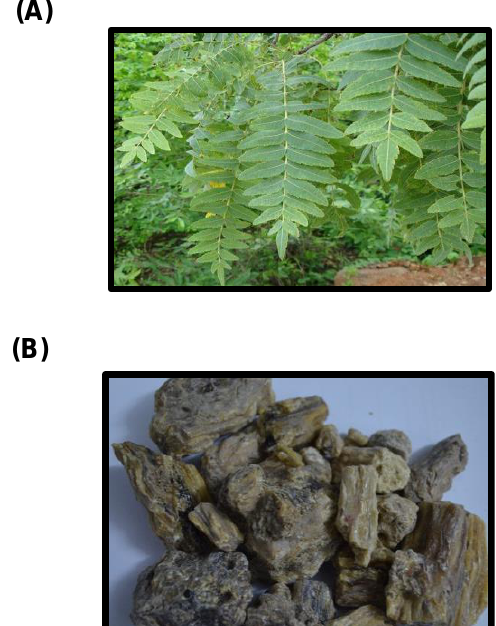
Figure 1. ( A ) Boswellia (Pankaj Oudhia/www.discoverlife.org) and ( B ) Boswellia gum resin.